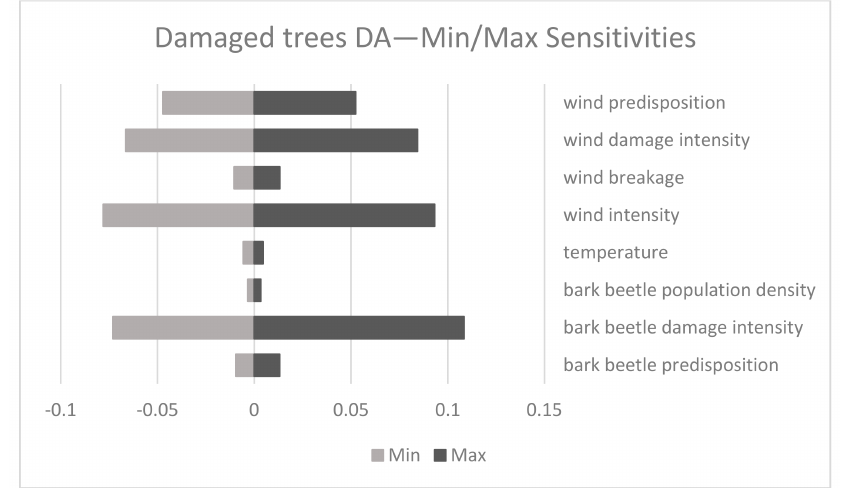
Figure 6. Sensitivities for the damaged trees network. “Wind damage intensity” shows the highest negative sensitivity (Min = − 0.078) while “bark beetle damage intensity” shows the highest positive sensitivity (Max =